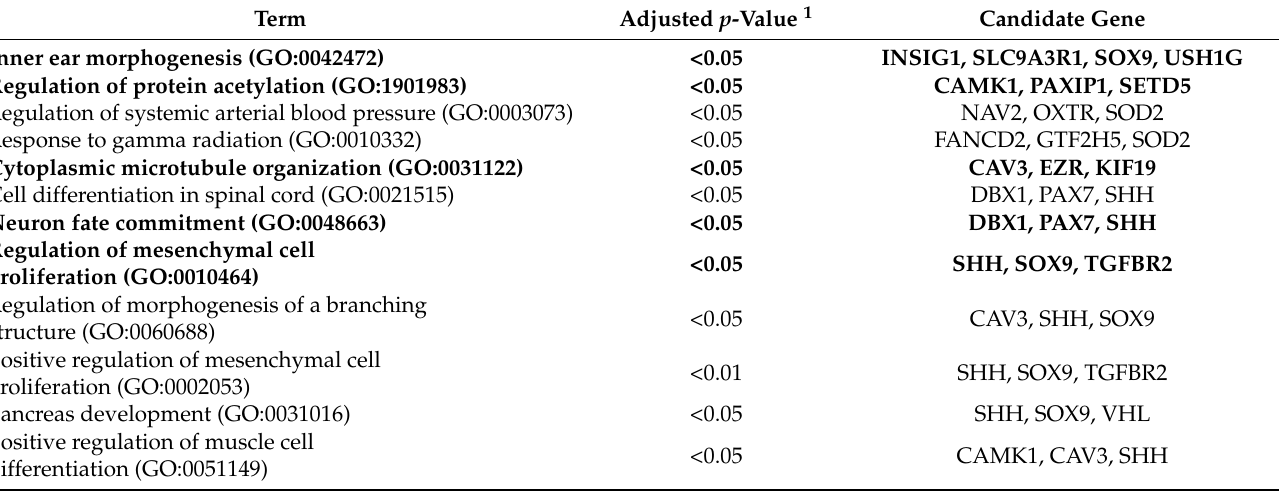
Table 3. Results of GO and KEGG pathway analyses associated with social genetic effect (SGE) in DUC